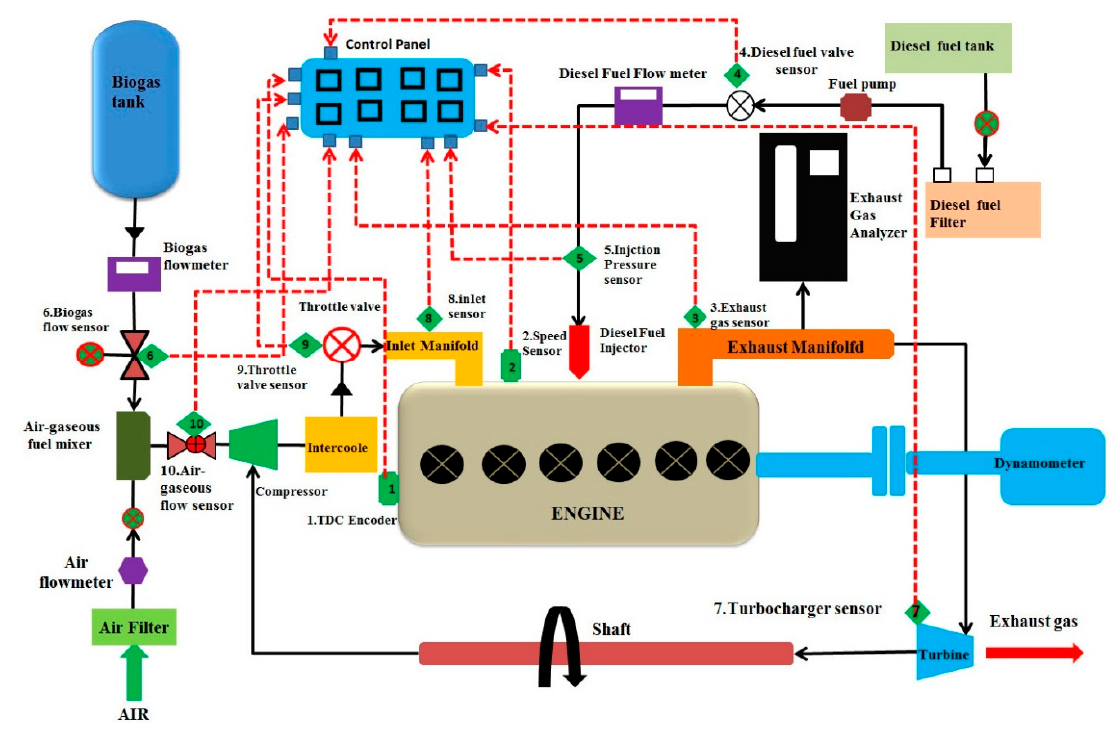
Table 2. Engine specifications.